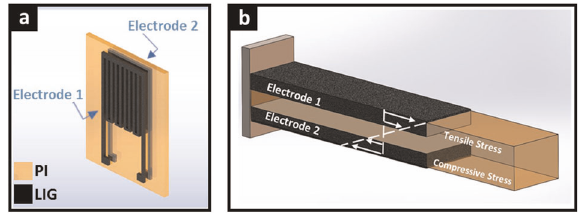
Fig. 6 Schematics of a a double-sided LIG bending sensor and b its cross-section with the stress, due to